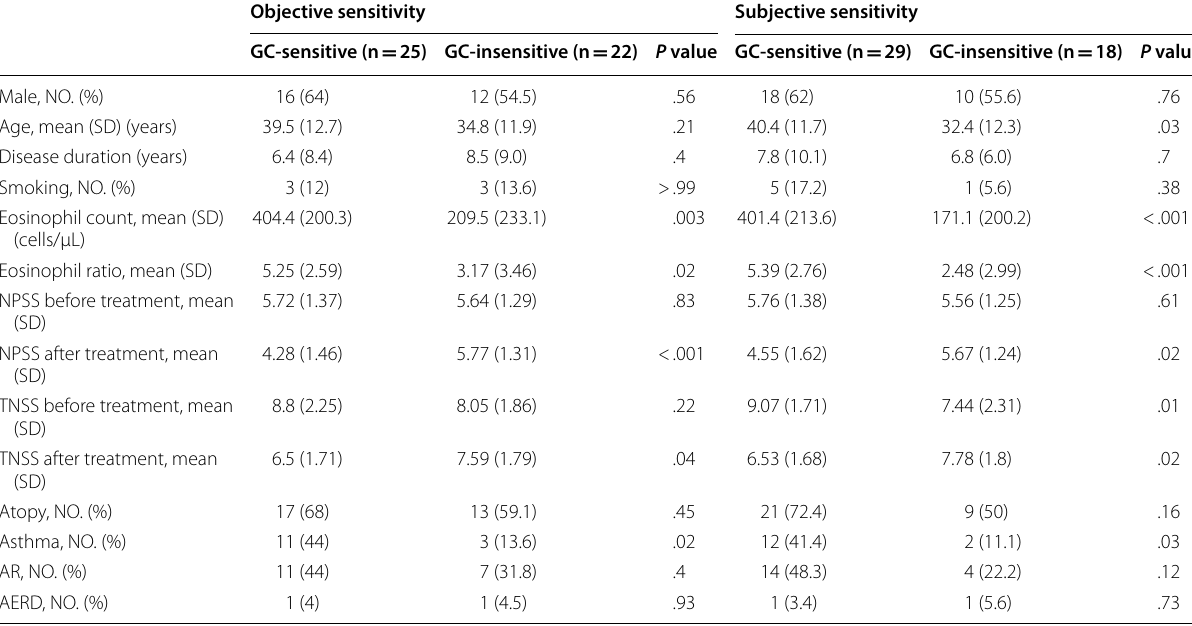
Table 1 Demographic data and blood eosinophil counts of patients with GC-sensitive NP and GC-insensitive NP